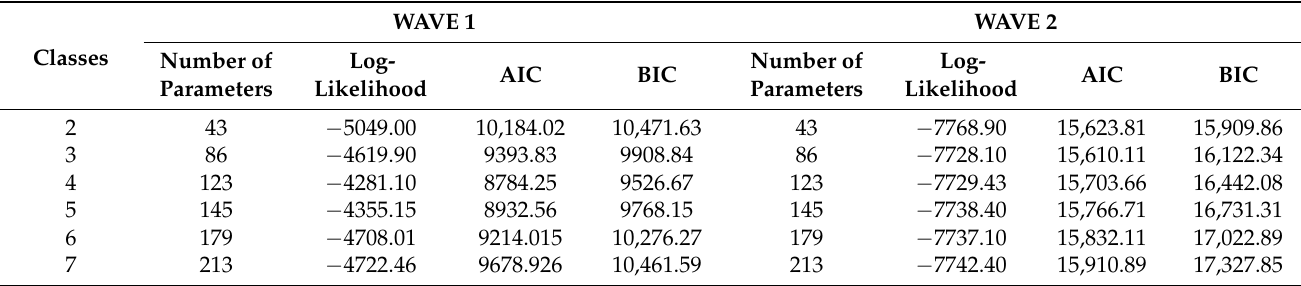
Table 3. Information criteria for the number of latent